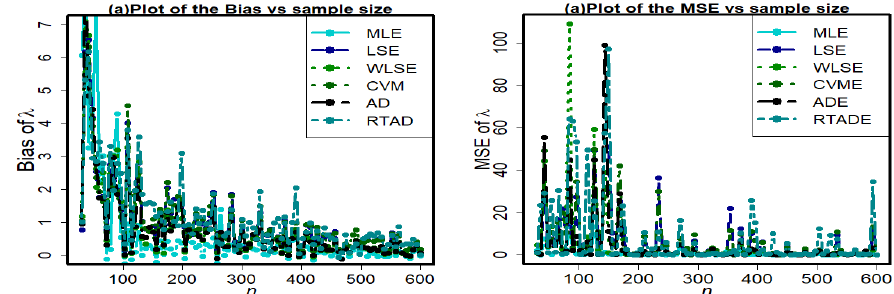
Fig. 8. Plot of theoretical and simulated PDF of HLUG-TI for certain parameters values.